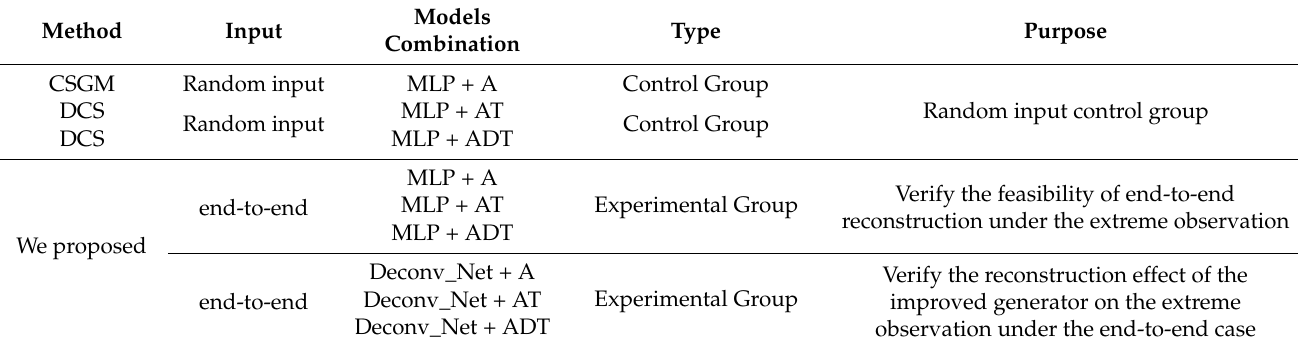
Table 2. Model combination of experimental and control groups.